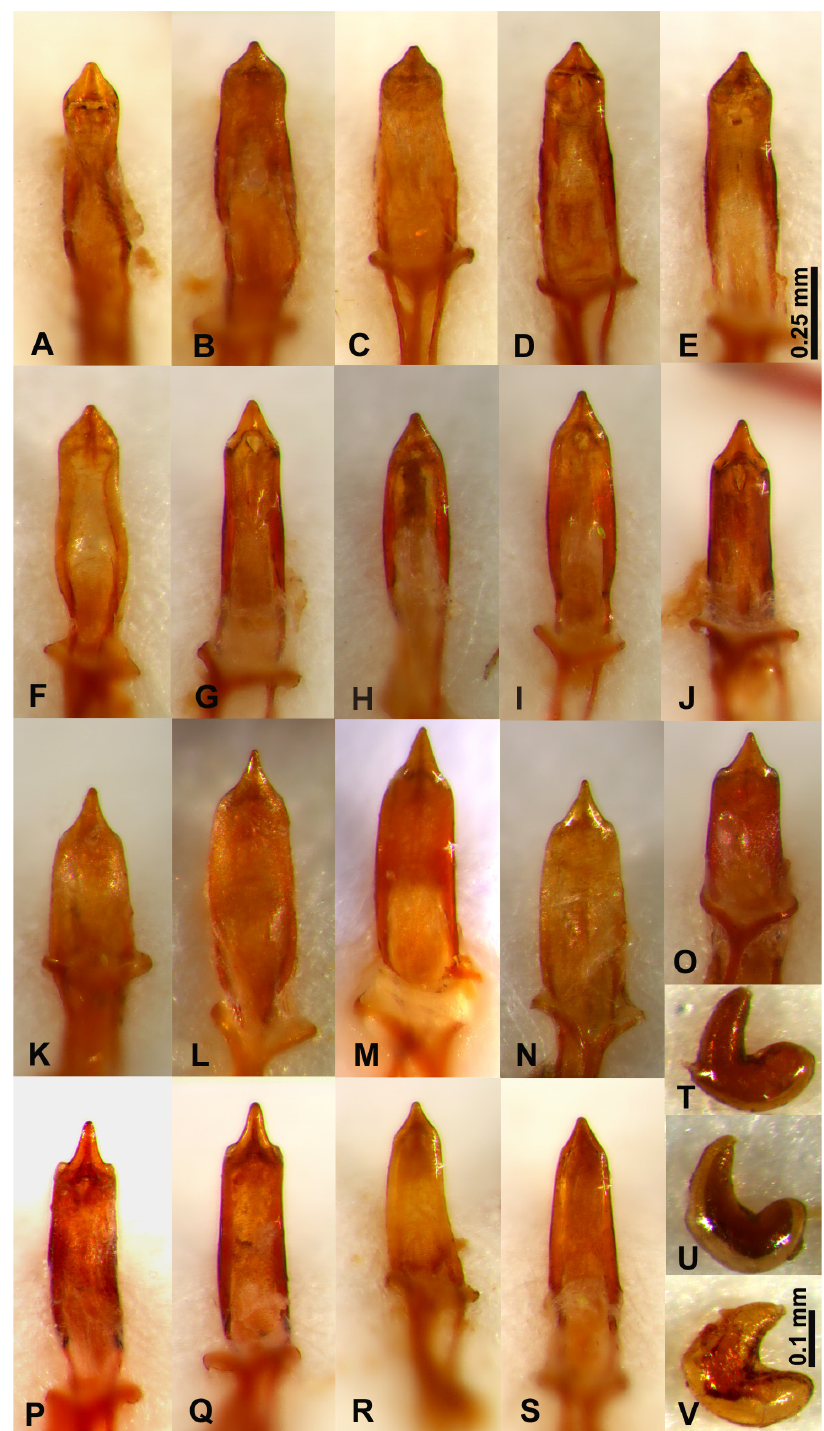
Fig. 2. A-F . Ventral view or aedeagus of Dichorrhinus geiseri sp. nov. A . Holotype. B-C .